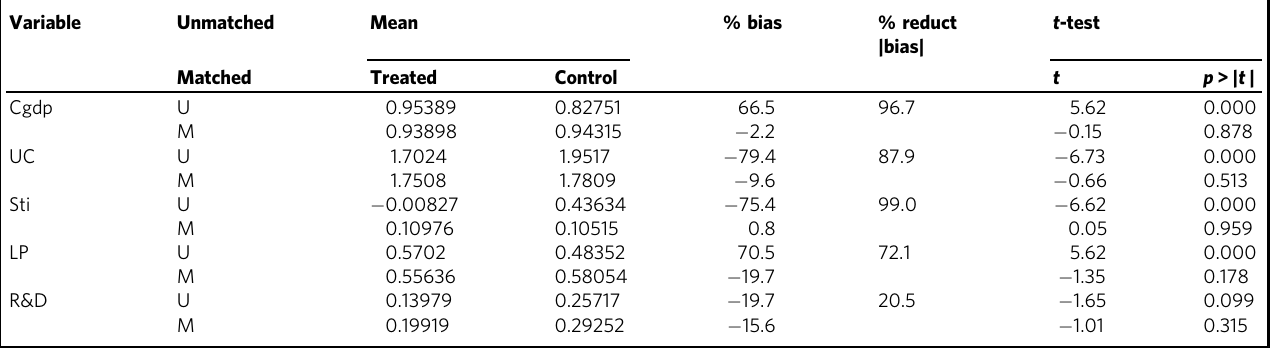
Table 4 The in fl uence of the B&R policy on the GD level of construction enterprises — DID. Variable